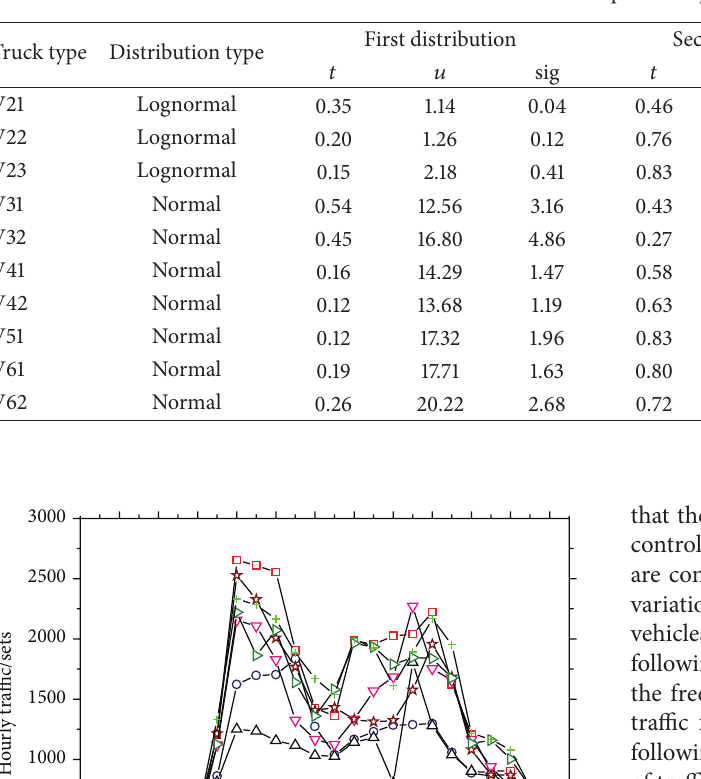
Table 4: Parameters of the mixed probability distribution for GVW.